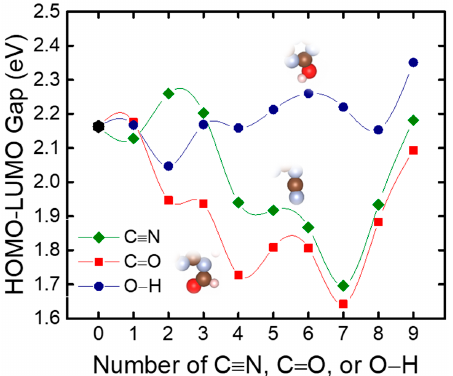
Figure 2. Calculated HOMO–LUMO gap vs a g-C 3 N 4 -6 structure with varying numbers of C ≡ N, C=O, and O − H. Configurations used for DFT calculations are shown in Figures 3–5. Insets show the functional groups in the calculated configurations. Brown, blue, pink, and red spheres represent C, N, H, and O, respectively. Nanomaterials 2018 , 8 , x FOR PEER REVIEW